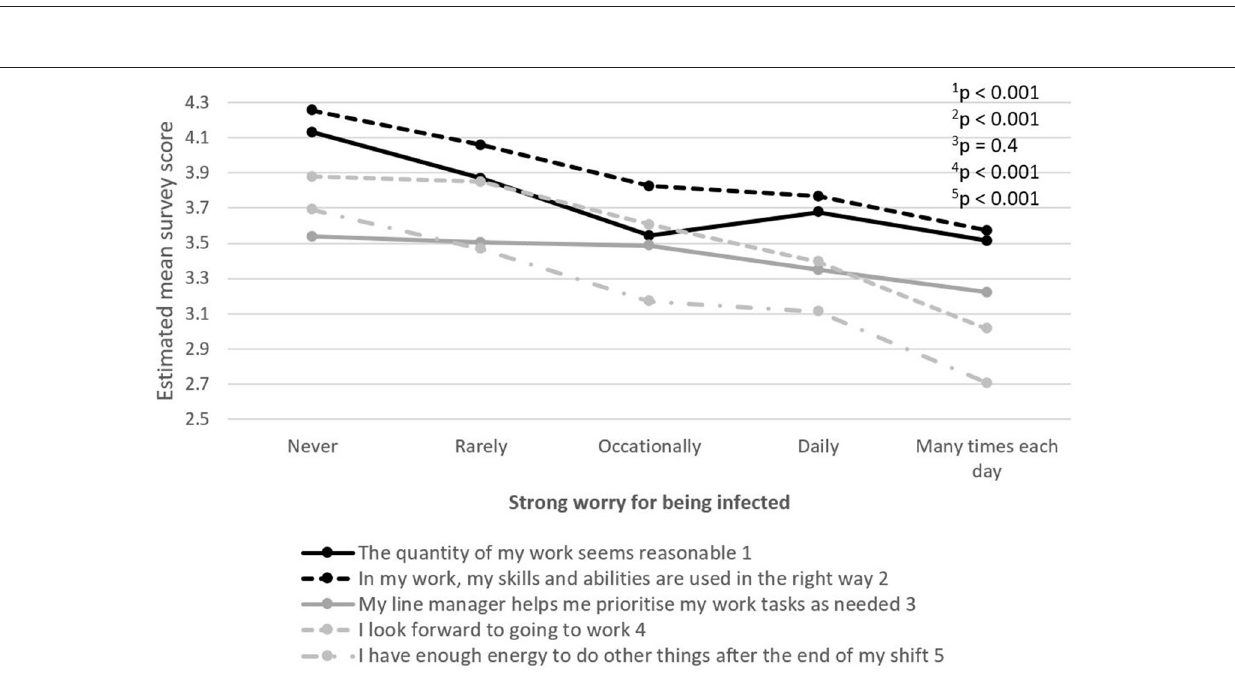
FIGURE 6 | The relationship between five selected work environment items in terms of job demands and resources, motivation and possibility for recovery, and strong worry of becoming infected with COVID-19. The item’s survey score ranges between 1 (strongly disagree) and 5 (strongly agree).